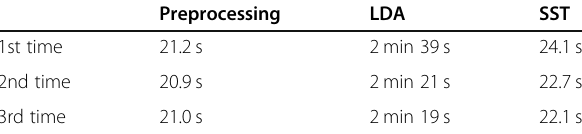
Table 2 Batch processing time for preprocessing, LDA, and SST Preprocessing